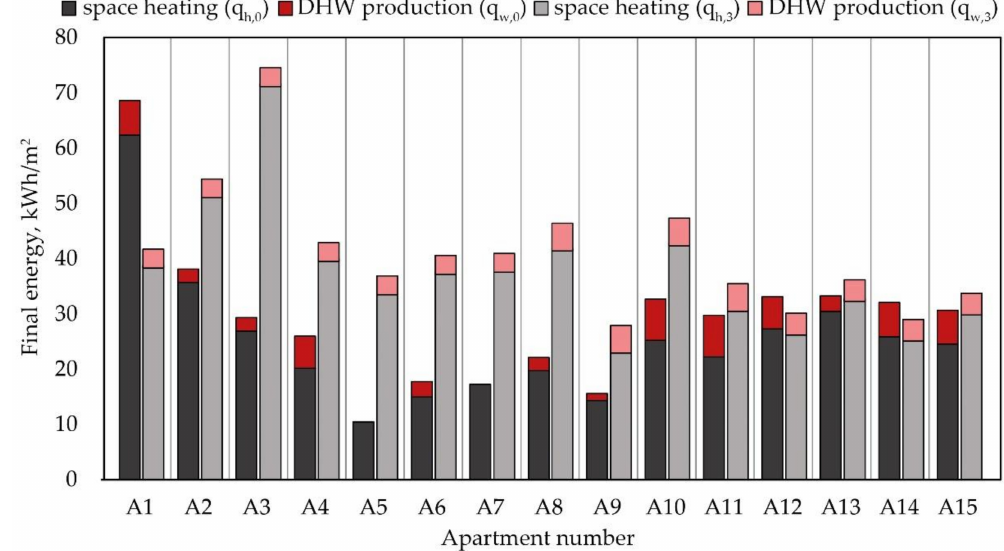
Figure 4. Final energy for space heating and domestic hot water (DHW) production: measurement vs. calculation.